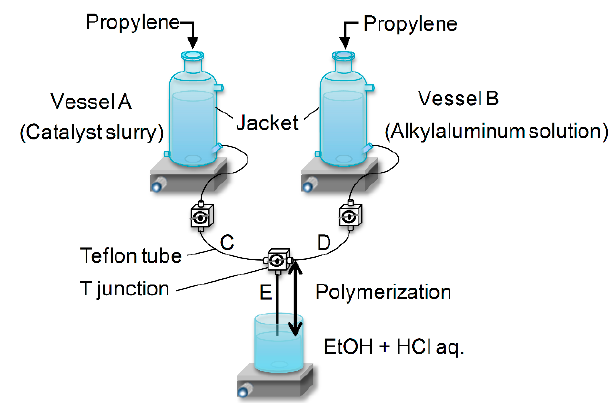
Figure 1. Conventional two-vessel stopped-flow (SF) apparatus [21].